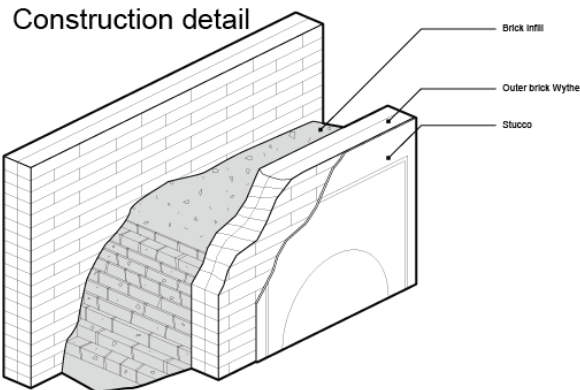
Figure 3: construction detail of historic masonry in Bagan, Myanmar